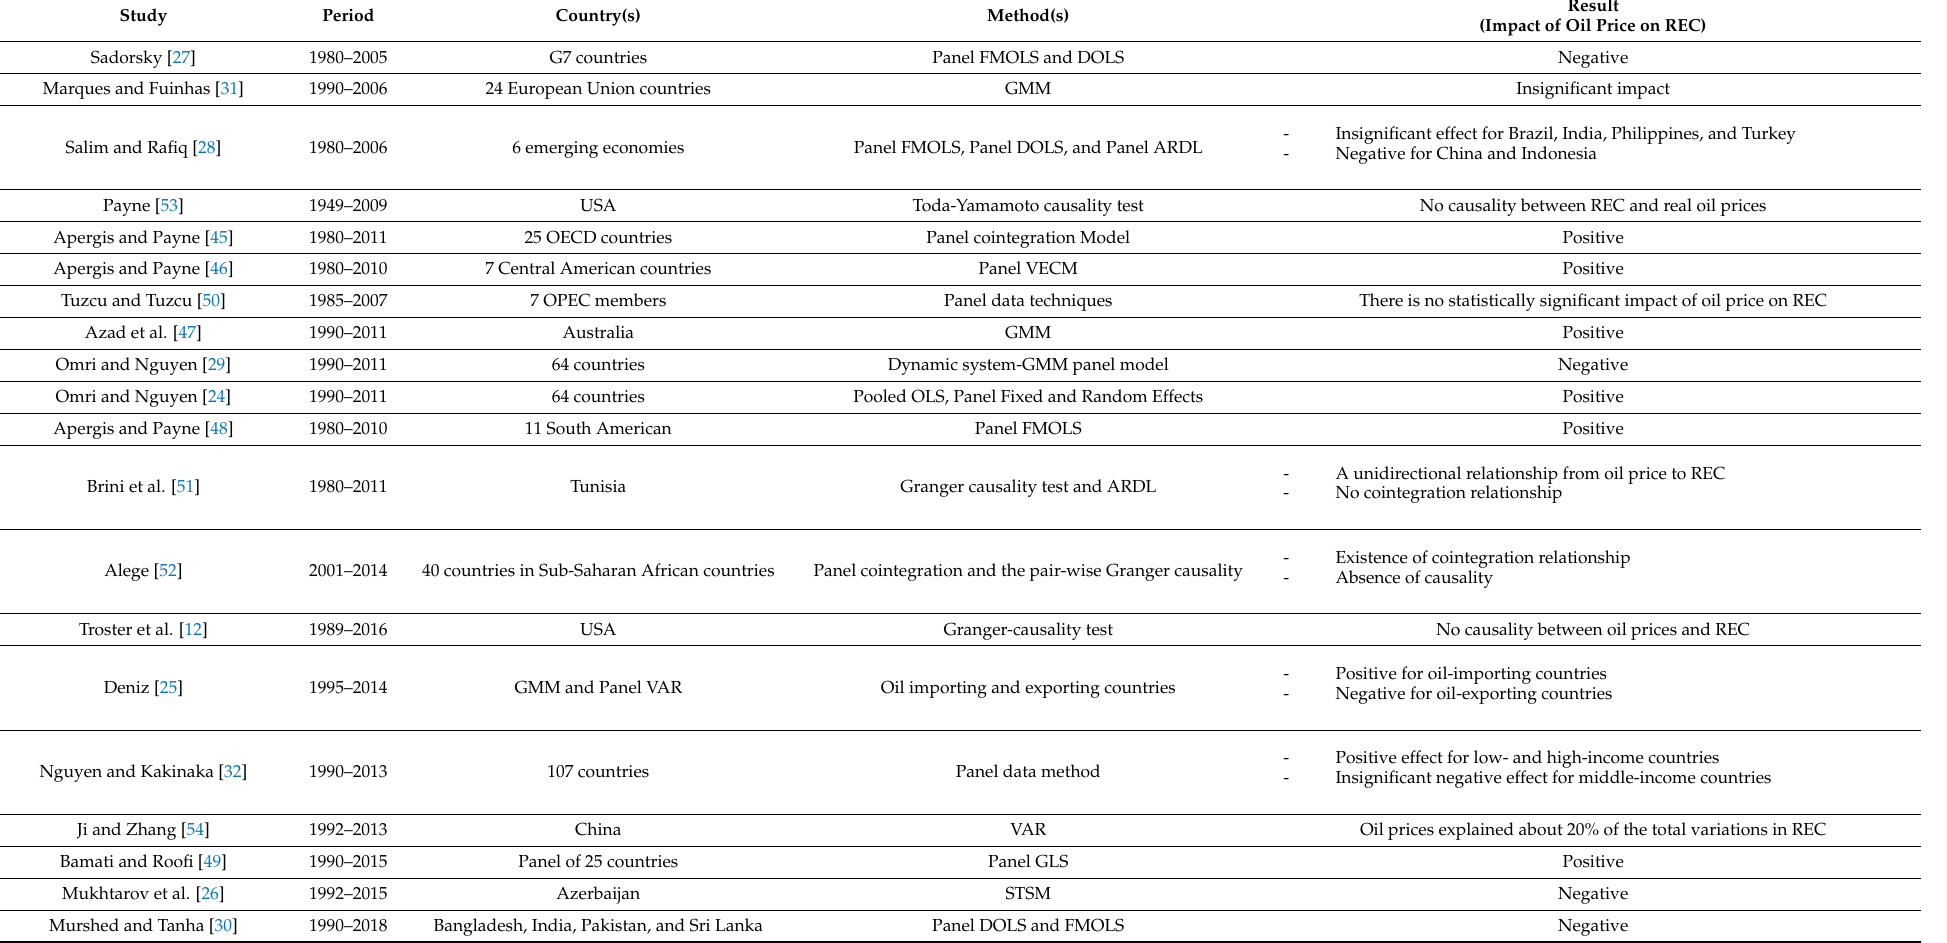
Table 1. An overview of the empirical